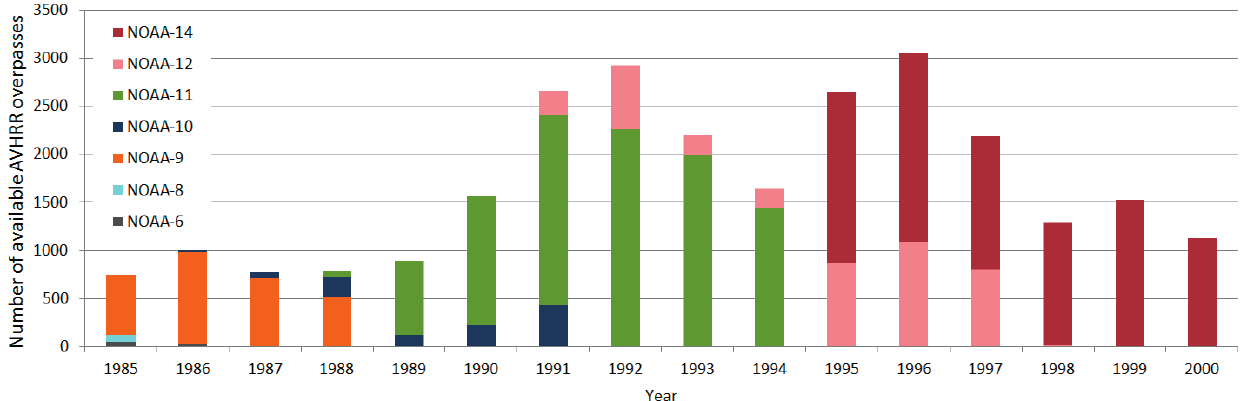
Figure 2. AVHRR data acquired from NOAA CLASS.